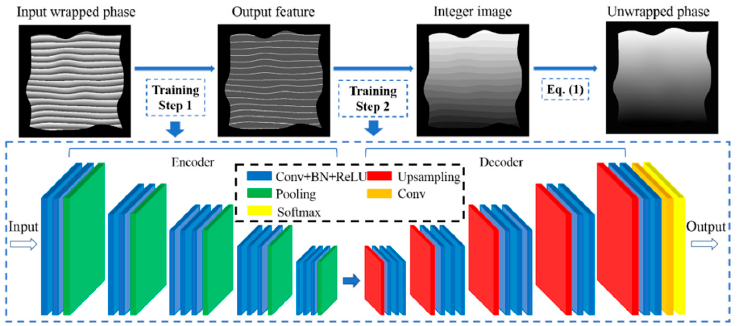
Figure 3. The workflow of the proposed method and the network architecture for phase unwrapping.